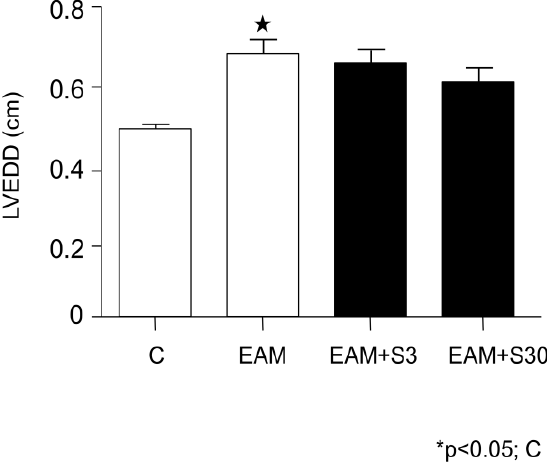
Figure 1. Effect of simvastatin on left ventricular end-diastolic diameter (LVEDD). C indicates not immunized group without simvastatin, EAM—group with induced EAM without simvastatin; EAM+S3—low-dosage simvastatin EAM group (3 mg/kg/d); EAM+S30—high-dosage simvastatin EAM group (30 mg/kg/d).